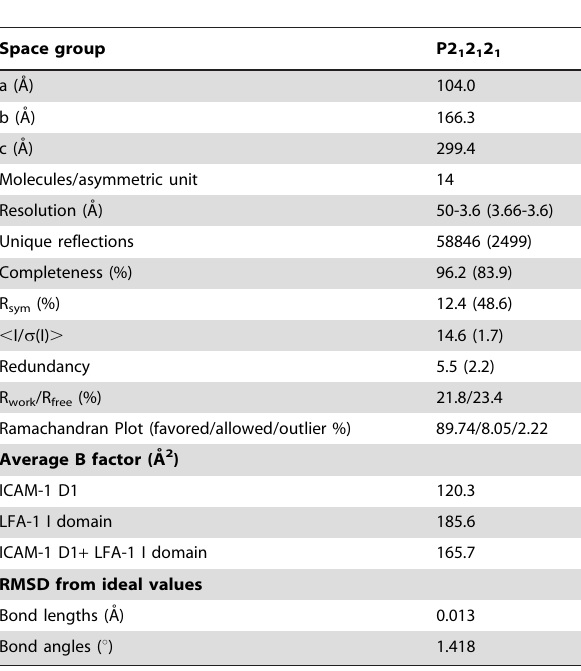
Table 1 . Data Collection and Refinement